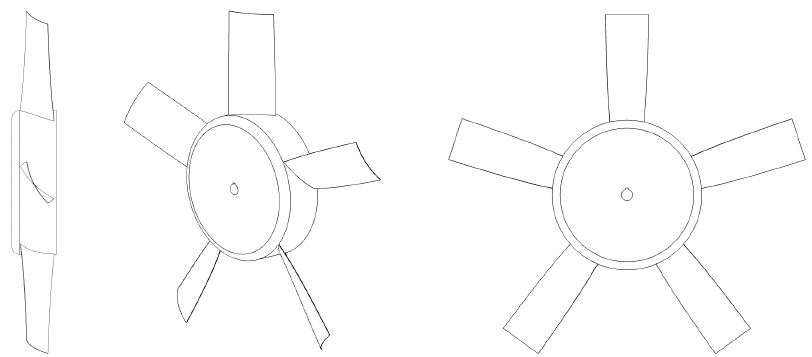
Figure 11. The PVS-affected fan rotor.